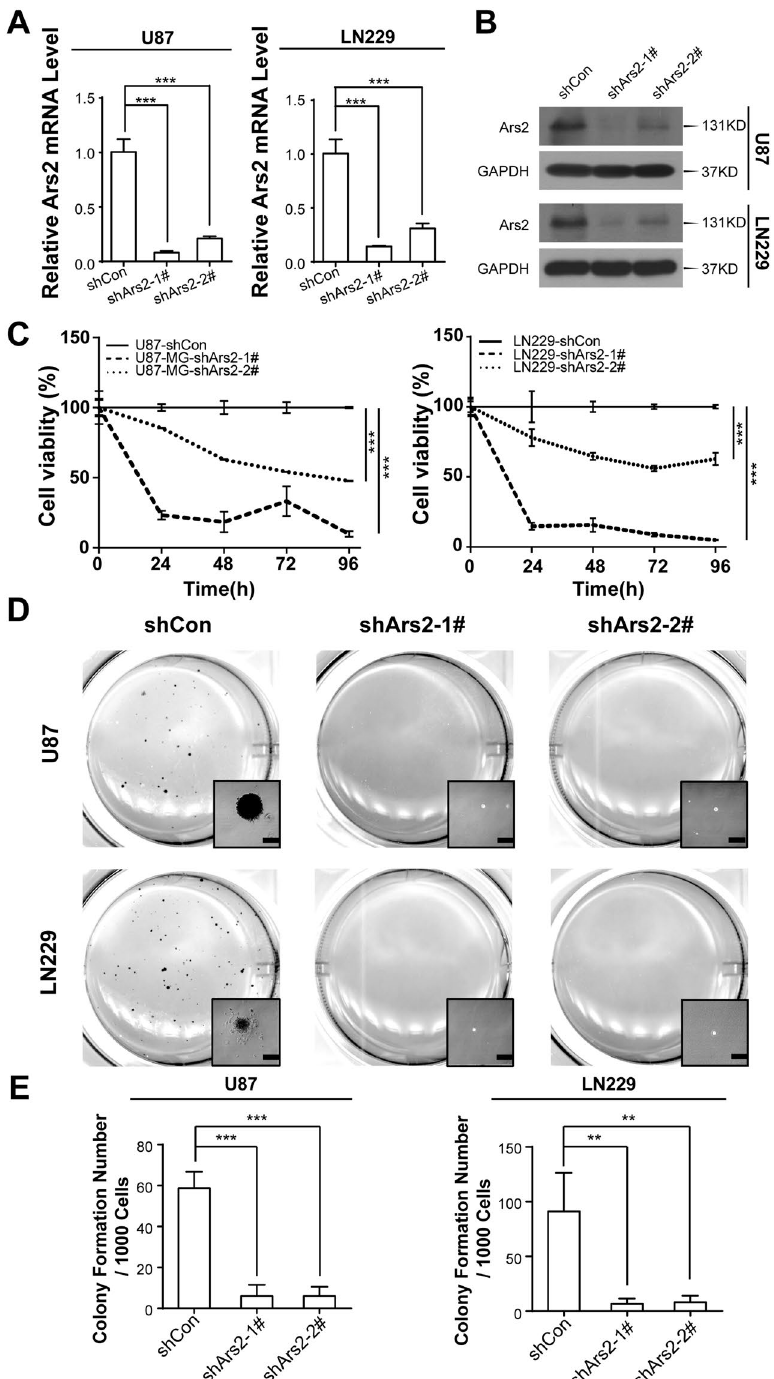
Figure 3. Depletion of Ars2 inhibited cell proliferation and colony formation in glioblastoma cells. U87 and LN229 cells were transfected with vector control siRNA (shCon) and Ars2 siRNA (shArs2-1#, and shArs2-2#). ( A ) Total RNA was isolated and Ars2 mRNA was quantified using qRT-PCR analysis. ( B ) Western blot assay was used to detect the expression of Ars2. ( C ) U87 and LN229 cells transfected with shCon and shArs2 were seeded into a 96-well plate (1000 cells/well), and cell proliferation was determined using MTT assay. ( D , E ) Colony formation was detected by soft agar assay. All data were represented as the mean ± SD for three separate experiments, ** P < 0.01, *** P <